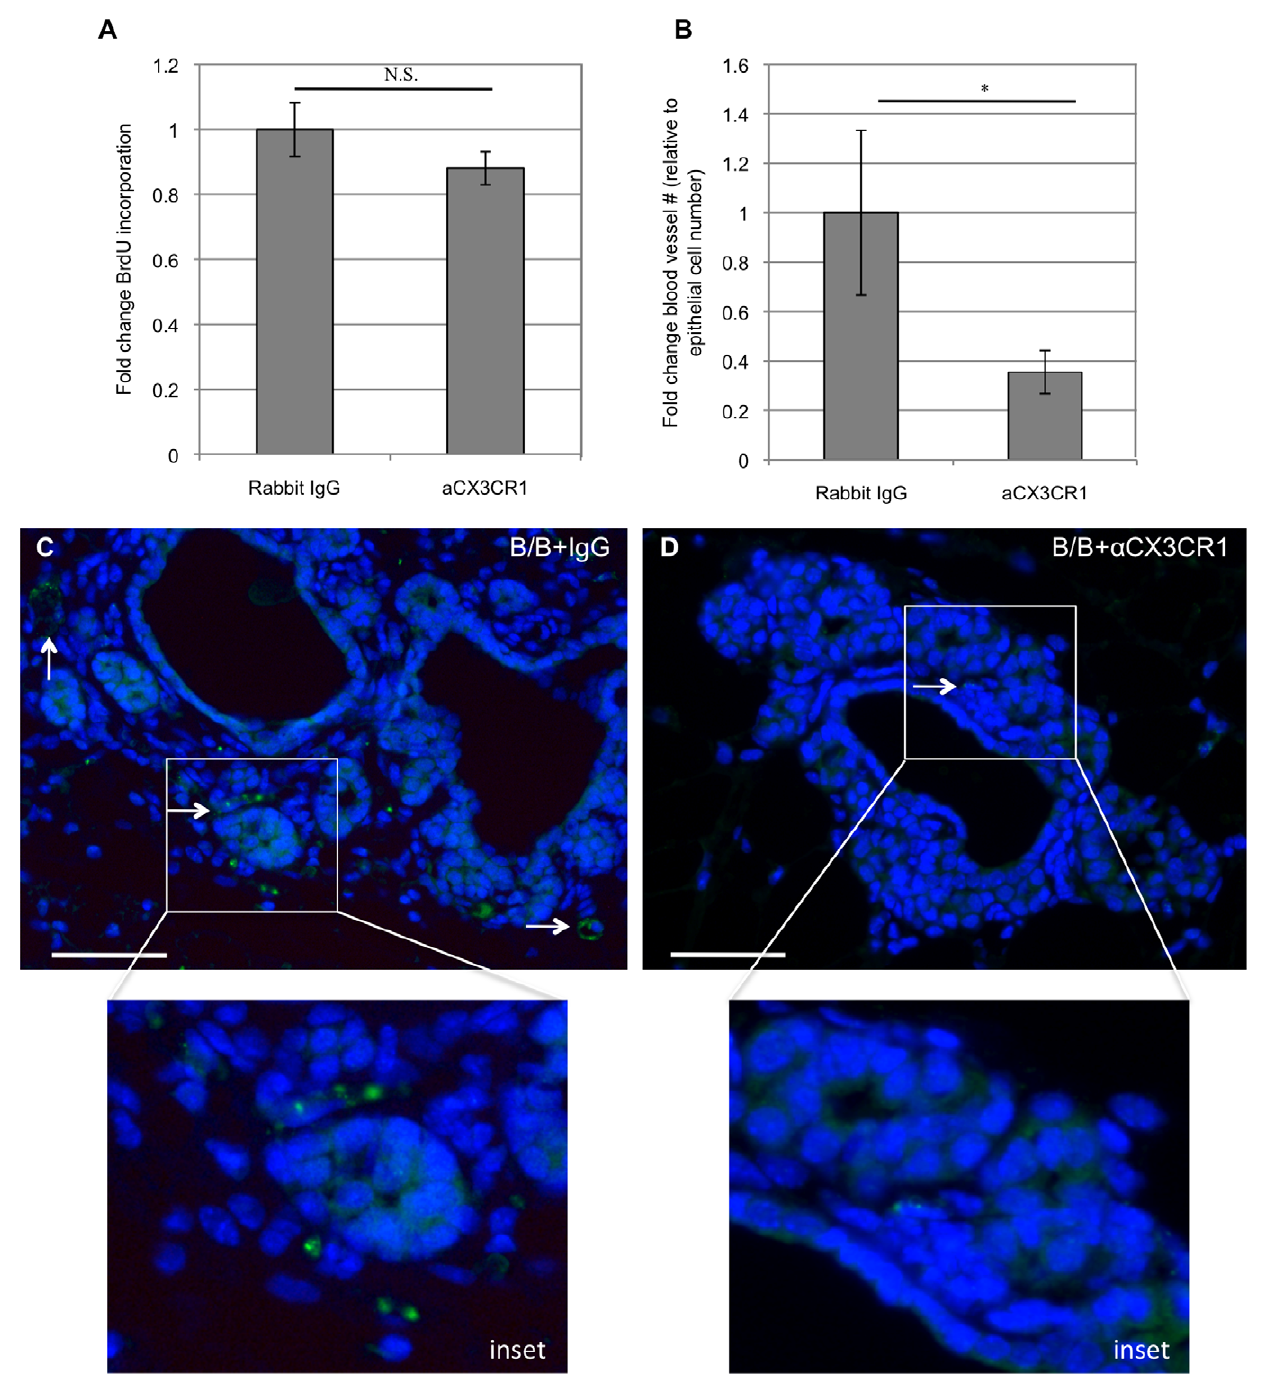
Figure 6. Decreased macrophage recruitment correlates with decreased angiogenesis. A) Quantification of BrdU incorporation demonstrates that decreased macrophage infiltration does not significantly correlate with a change in epithelial cell proliferation (N.S.=not significant). B) Quantification of VWF staining reveals decreased blood vessels associated with epithelial structures in mammary glands from mice treated with B/B and anti-CX3CR1 blocking antibody compared with mice treated with B/B and IgG control antibody. *p , 0.05. C, D) Representative images of VWF stained mammary glands from mice treated with B/B and either control IgG antibody (C) or anti-CX3CR1 (D). Green=VWF staining, blue=DAPI. Arrows indicate VWF-positive structures. Scale bars represent 50 m M. Results in each figure panel are representative of a minimum of three different mice for each treatment group and genotype. doi:10.1371/journal.pone.0045877.g006 which tumor cell-secreted CX3CL1 interacts with CX3CR1- In this paper we have shown for the first time that iFGFR1- expressing cells of the surrounding tumor microenvironment induced CX3CL1 regulates the migration of macrophages during during early mammary tumor formation. the initial stages tumor formation. Since tumor associated